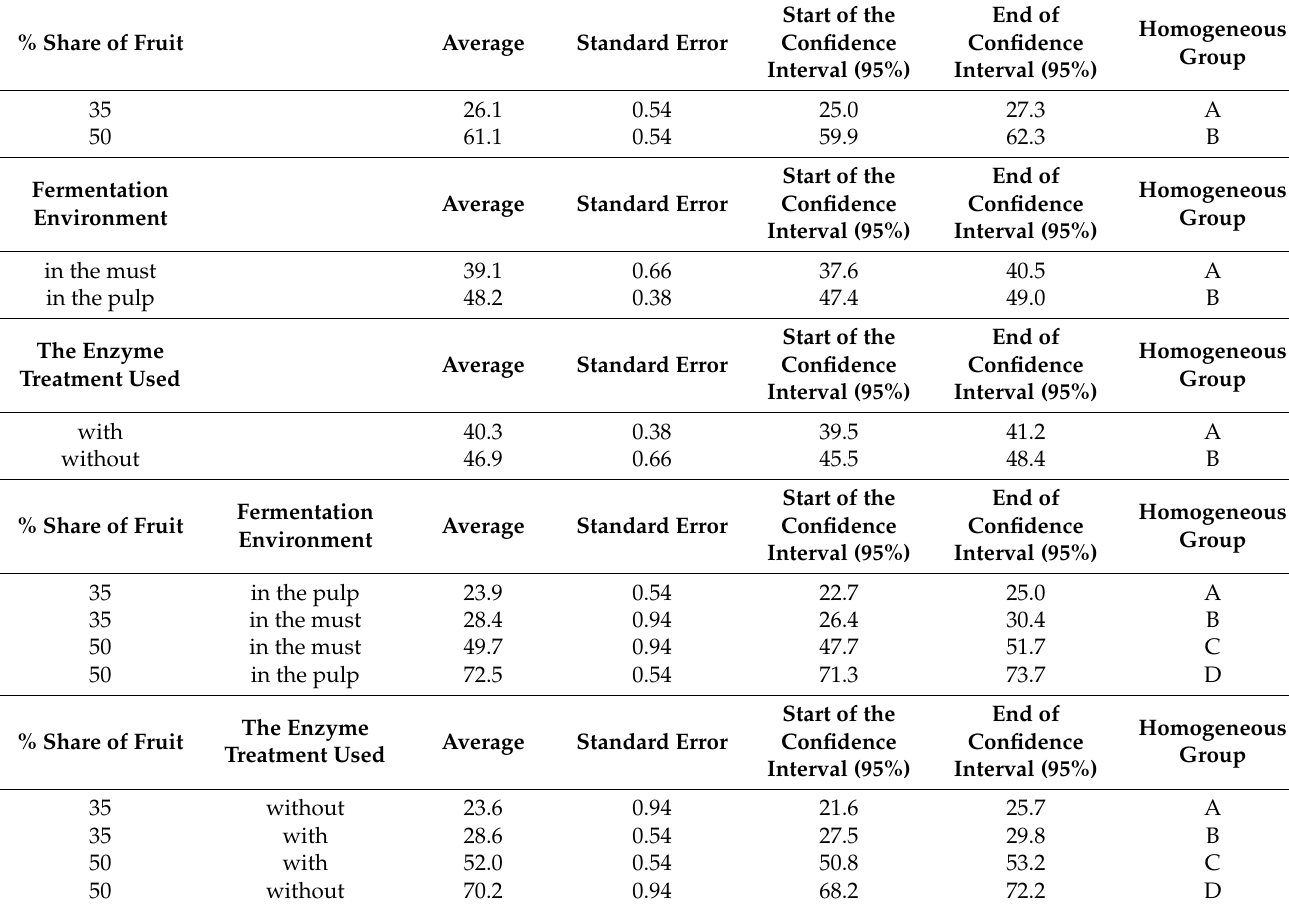
Table 4. Multivariate analysis of variance of the dependence of DPPH radical scavenging ability by 0.625% wine solutions after 3 months of aging on the share of fruit (a), fermentation in must or pulp (b), enzymatic treatment or its absence (c), and a combination of factors a * b and a *